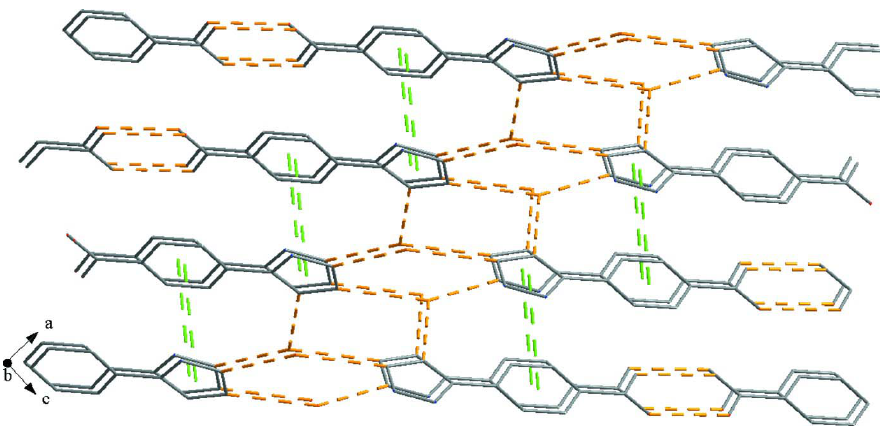
Figure 3 A three-dimensional framework for (I) linked by the π - π stacking interactions (green dashed lines). Hydrogen bonds are shown as yellow dashed